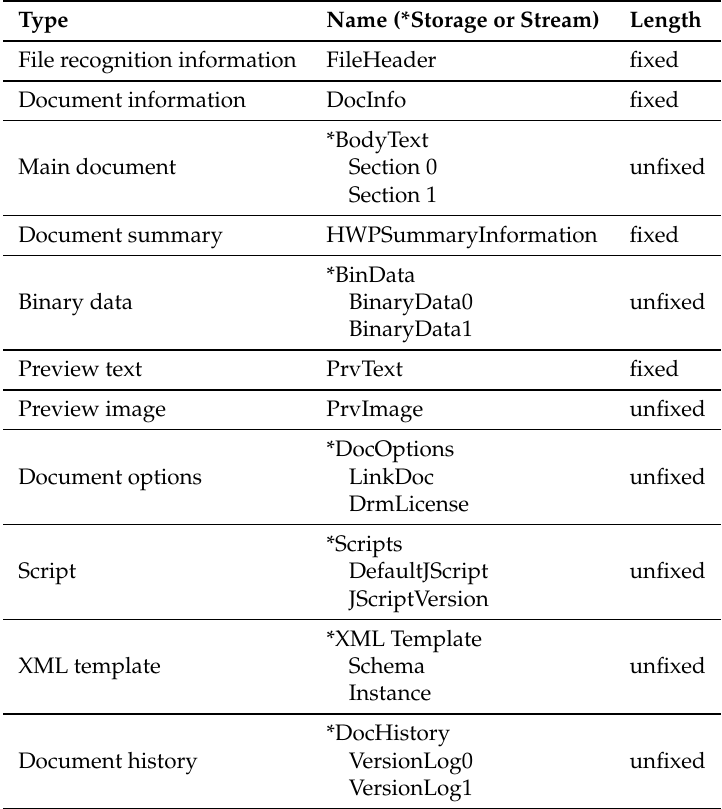
Table 1. Structure of